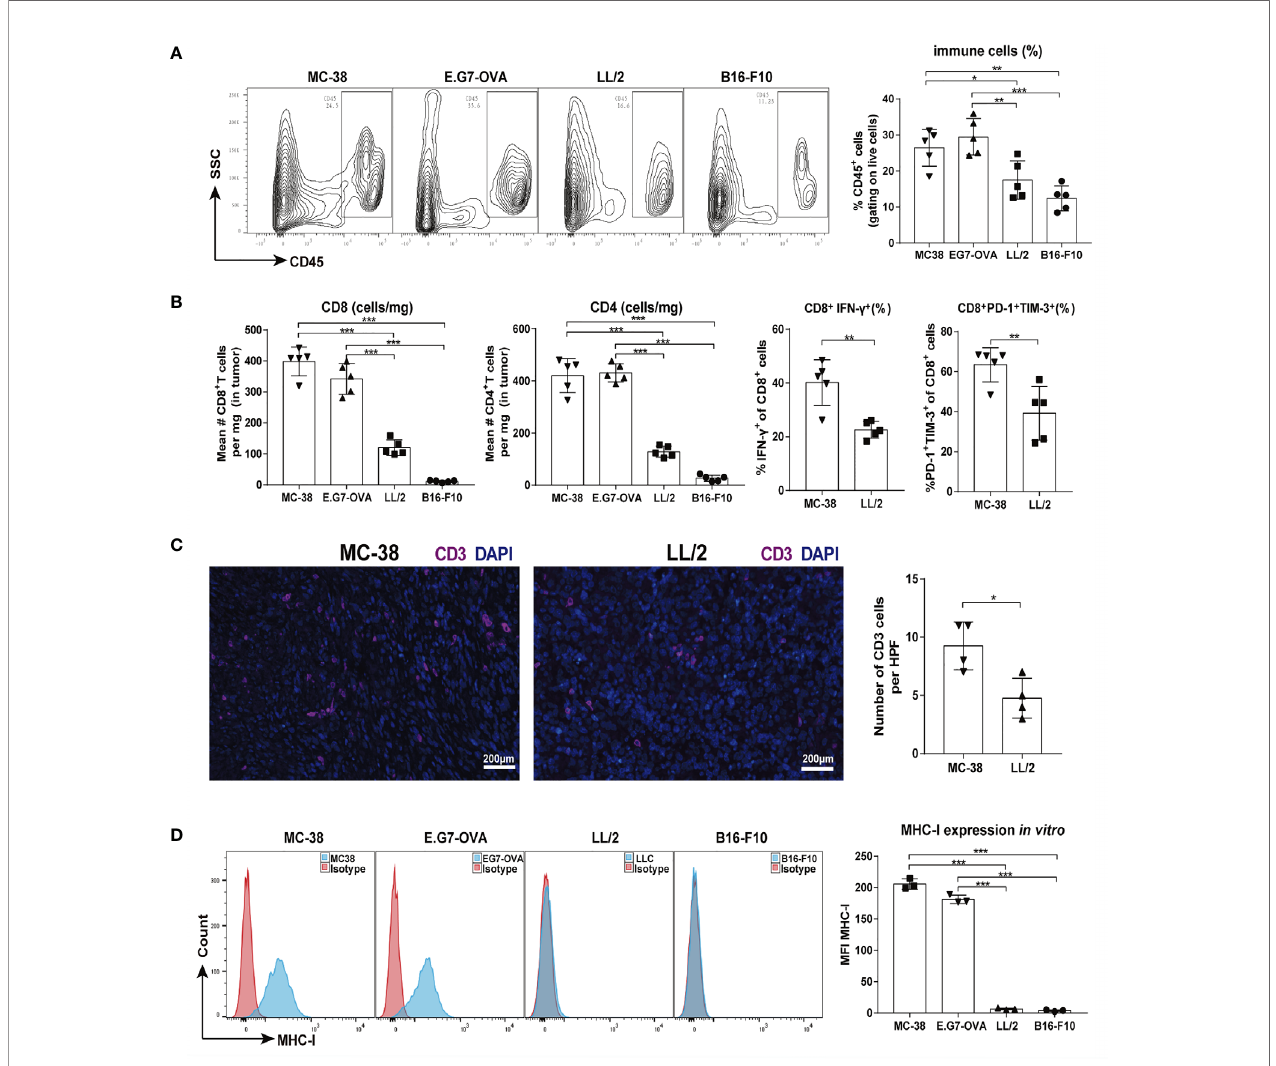
FIGURE 1 | Tumor immunogenic levels of four murine tumors. Mice were inoculated with MC-38, E.G7-OVA, LL/2 and B16-F10 tumors, and then tumor in fi ltrating cells were isolated for cytometry analysis when the tumor lengths reached approximately 5 – 6 mm (on days 7 – 9). (A) Percentages of CD45-positive lymphocytes in four types of tumor tissues are shown in representative FACS plots (left graph) and pooled from two independent experiments. (B) Absolute numbers of CD8 T and CD4 T cells in four types of tumor tissues were counted, and percentages of CD8 + IFN- g + and CD8 + PD-1 + TIM-3 + cells were analysed in MC-38 and LL/2 tumor tissues. (C) In fi ltrating T cells in MC-38 and LL/2 tumors were stained with anti-CD3 (purple) and DAPI (blue, nuclei staining) and detected by immuno fl uorescence. Scale bars, 200 m m. (D) Histograms of MHC-I molecule expression on MC-38, E.G7-OVA, LL/2 and B16-F10 cells in vitro . Representative results from one of at least three independent experiments are shown. * p < 0.05, ** p < 0.01, *** p <